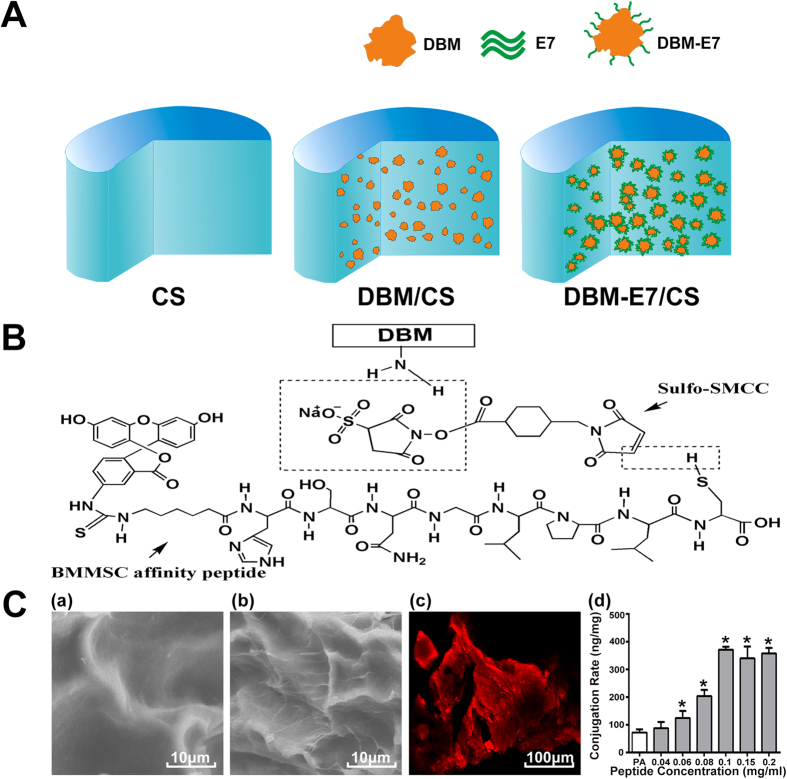
Schematic illustration of the three different structural scaffolds, the conjugating process of E7 peptide to DBM particles and characterization of DBM-E7 particles.(A) CS scaffold is composed of pure CS hydrogel, DBM/CS scaffold is a mixture of CS hydrogel and DBM particles, and DBM-E7/CS scaffold is composed of DBM-E7 particles blended in CS hydrogel. (B) BMMSCs affinity peptide was covalently conjugated with DBM via cross-linker of sulfo-SMCC. SEM images of representative areas of (C a) DBM and (C b) DBM-E7 particles. (C c) Confocal scanning of DBM-E7 particle with red fluorescence of rhodamine. (C d) Quantification of the amount of peptide conjugated to scaffolds (PA, physical adsorption; *p < 0.05 vs. PA).